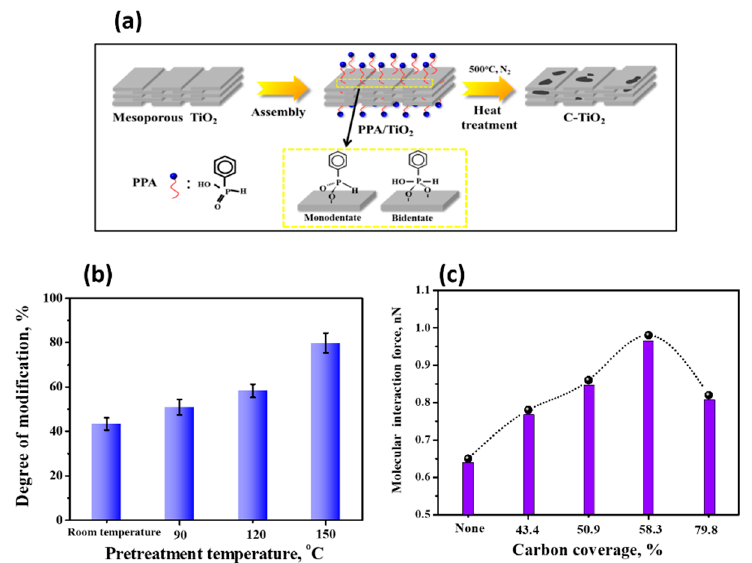
Figure 5. ( a ) Schematic diagram of the surface chemical modification of mesoporous TiO 2 to obtain C-TiO 2 ; ( b ) Different pretreatment temperatures corresponded to different carbon coverages of C-TiO 2 ; ( c ) The relationship between the molecular force of protein molecule with C − TiO 2 with different carbon coverages. Reprinted from Ref. [86] with permission from American Chemistry Society.